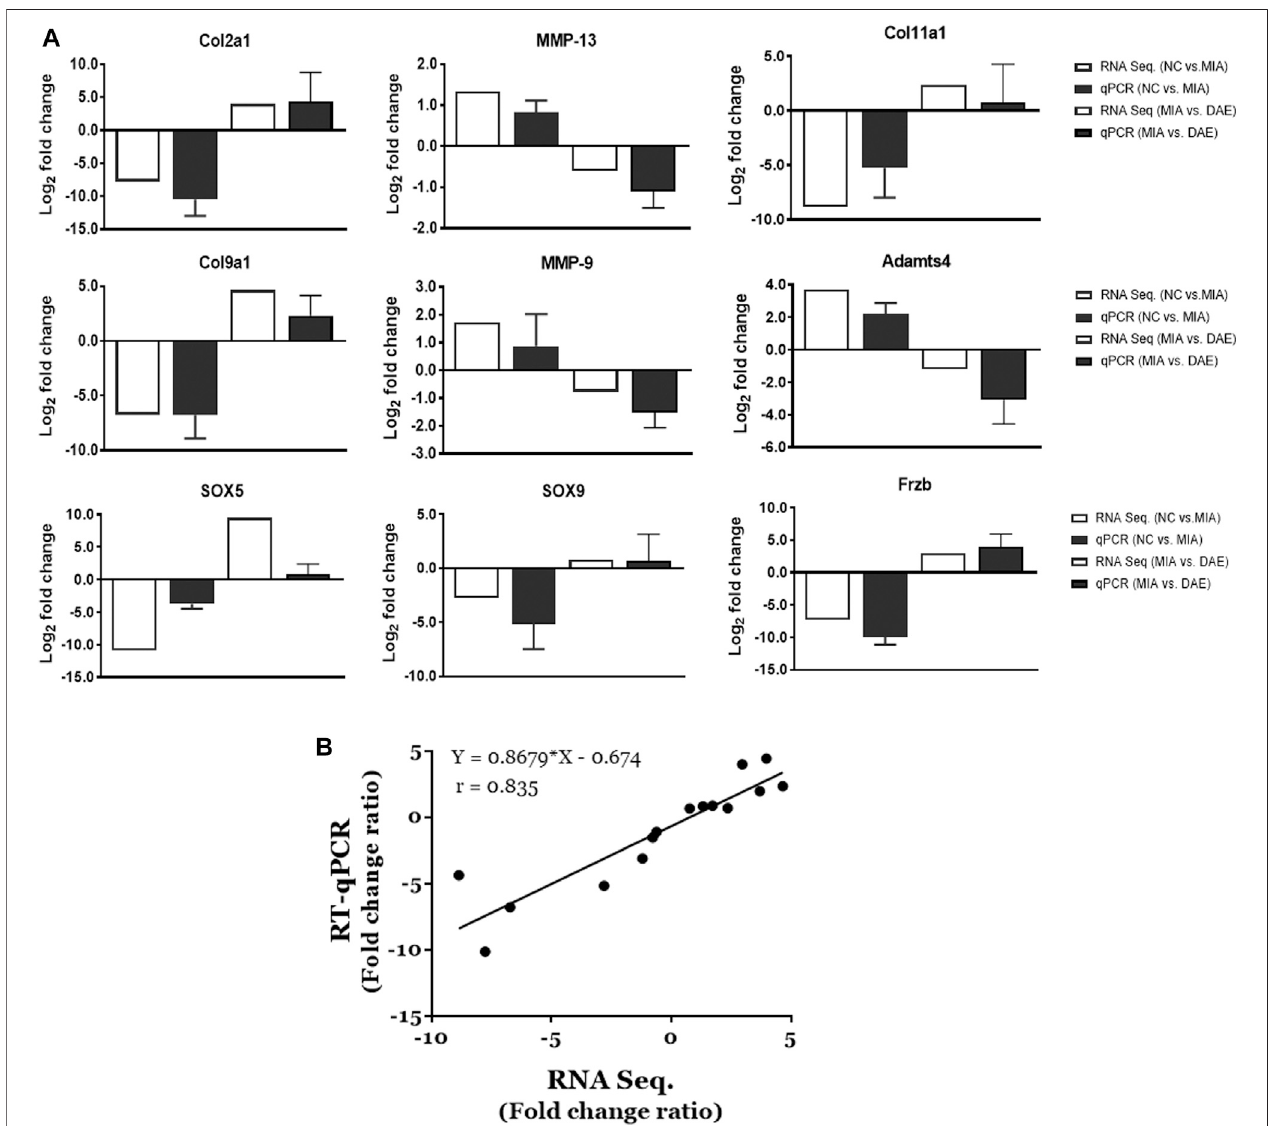
FIGURE 5 | Validation of the mRNA expression of selected genes induced by monosodium iodoacetate (MIA) and Dipsacus asperoides ethanolic extract (DAE) in articular cartilage tissue. (A) Comparison of log2 fold changes in the expression of selected genes measured by RNA-seq and RT-qPCR in saline- vs. MIA-treated rats and MIA- vs. MIA + DAE-treated rats. RNA-seq data are presented as log 2 -transformed mean fold changes in gene expression. The RT-qPCR data are shown as log 2 - transformed mean fold changes ± SD ( n (cid:2) 3 – 5 per group). NC, rats given saline (vehicle); MIA, rats injected with MIA; MIA + DAE, rats injected with MIA and given DAE. (B) The correlation between gene expression data measured by RNA-seq and RT-qPCR. The Pearson correlation coef fi cients and linear regression line are indicated.